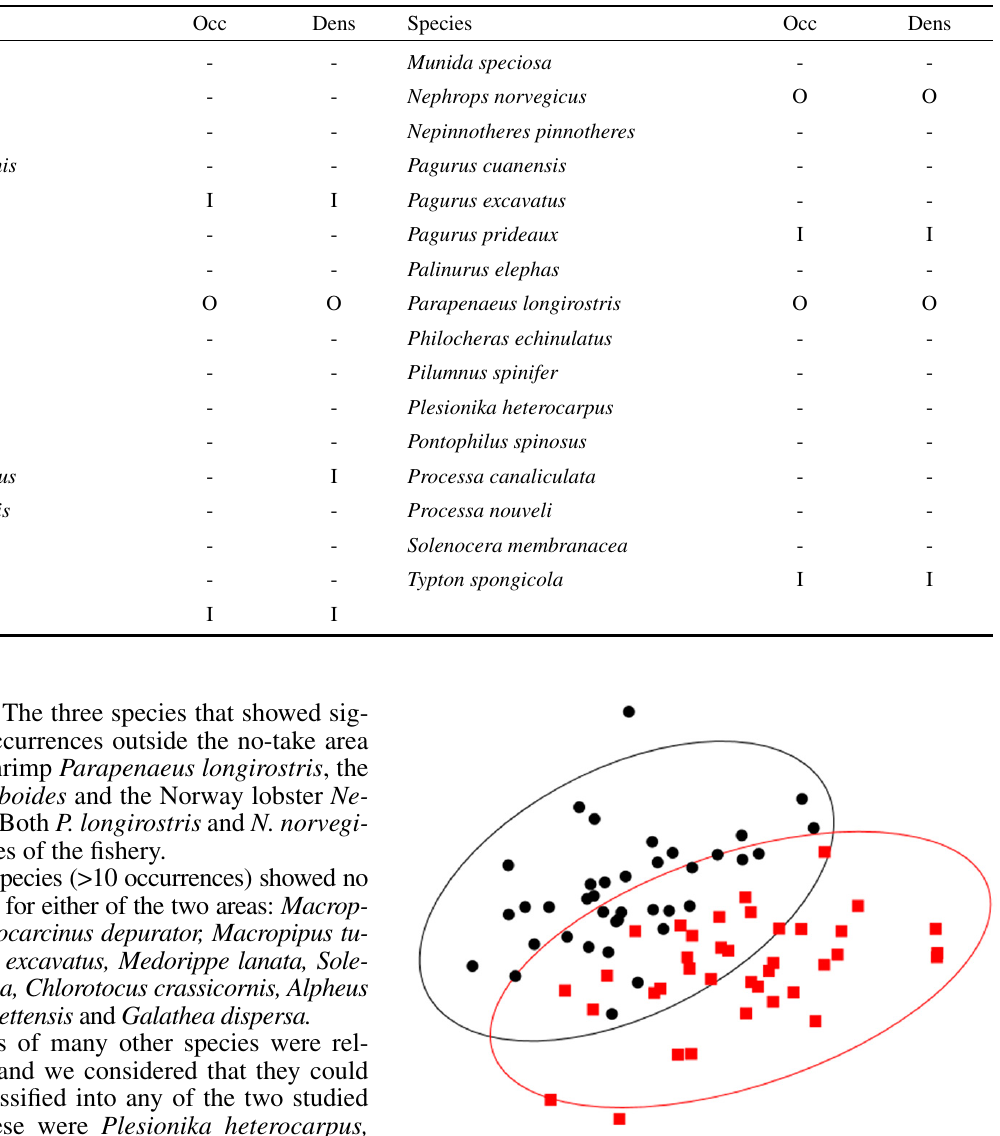
Table 4. – Joint characterization of species according to the significance of their occurrences (Occ) and density (Dens) inside (I) and outside (O) the no-take area. Dash indicates non-significant differences.